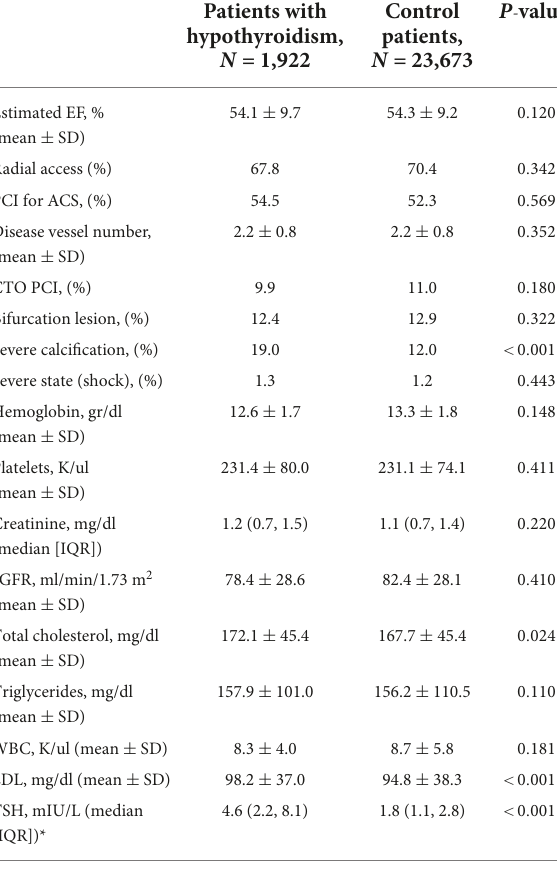
TABLE 2 Main clinical parameters at